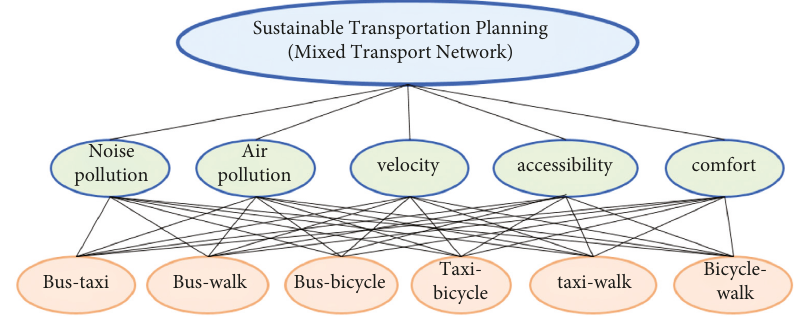
Figure 3: Hierarchical